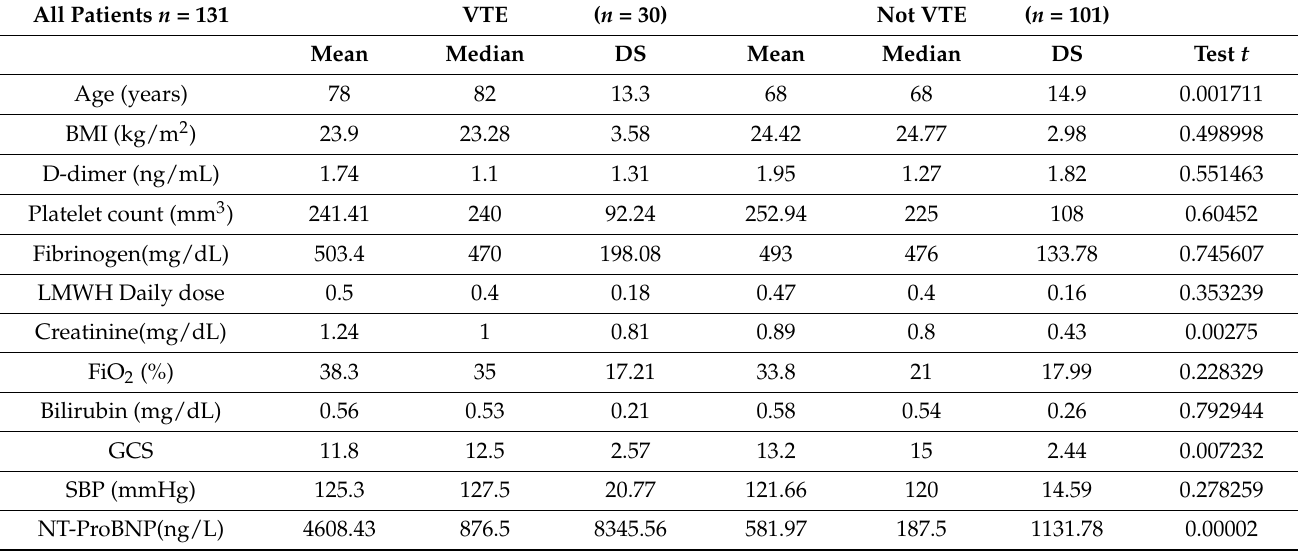
Table 3. Characteristics of patients who developed VTE and who not. BMI = Body Mass